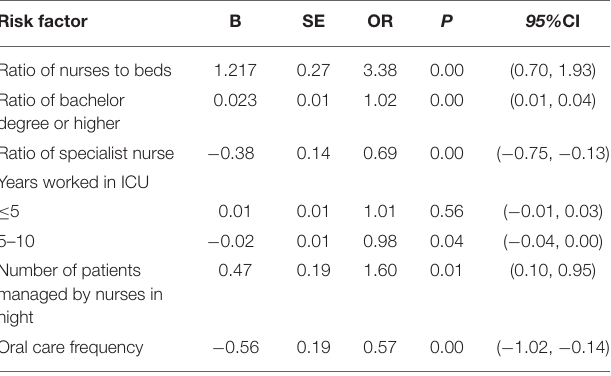
TABLE 4 | Nursing factors affecting the incidence of ventilator-associated pneumonia